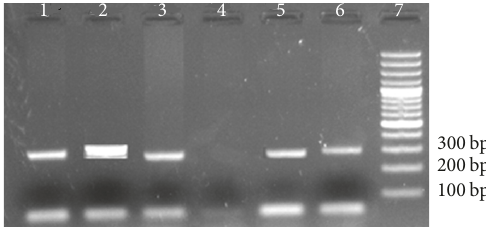
Figure 3: Agarose gel electrophoresis of amplified product obtained by 16S rRNA PCR using Plasmodium species-specific